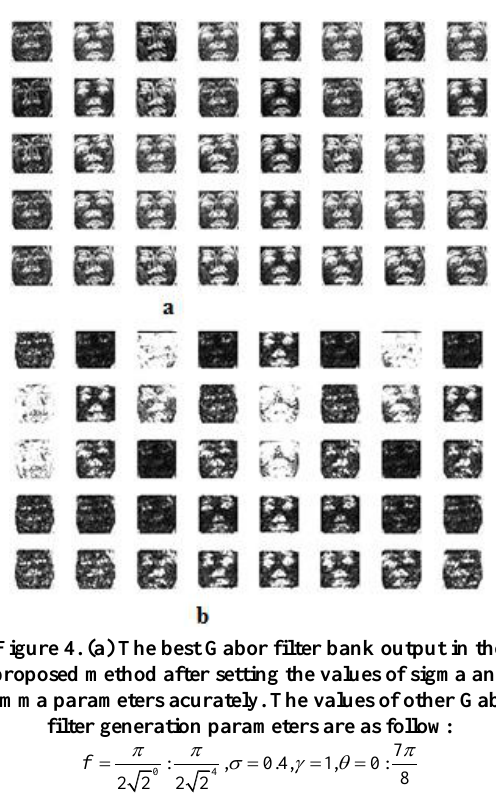
Figure 5. The ability of the selected Gabor filter on the images with different skin colors, virtual and non-virtual images and with low intensities in face area: (a) original image, (b) the Gabor-energy, and (c) the Gabor-energy converted to black and white